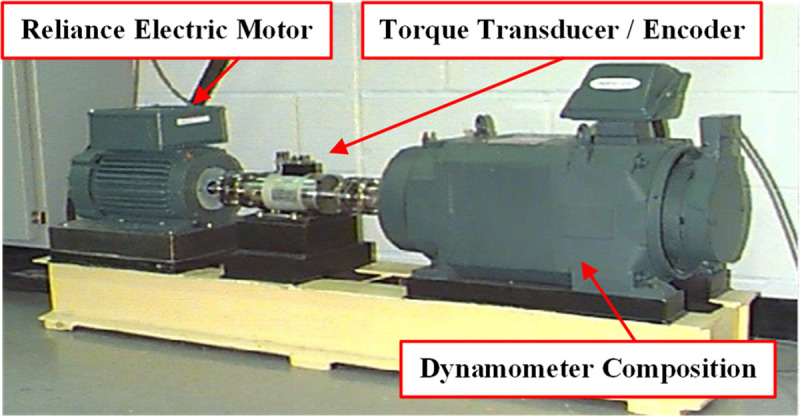
Experiment platform.